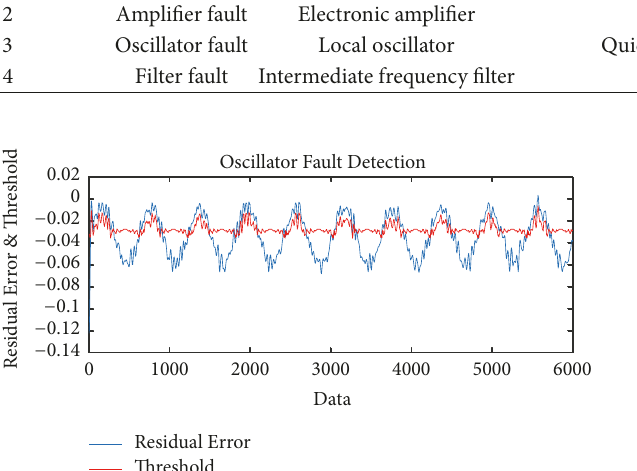
Figure 8: Detection result for oscillator fault.